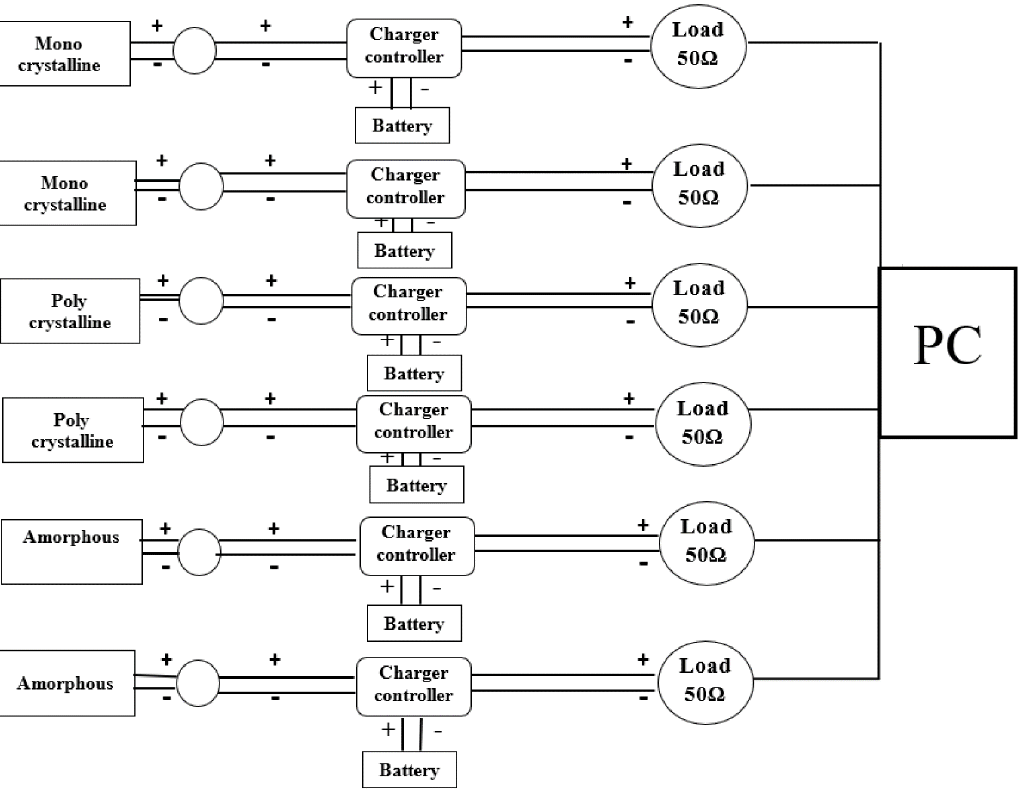
Figure 2. Block diagram of stand-alone photovoltaic systems.